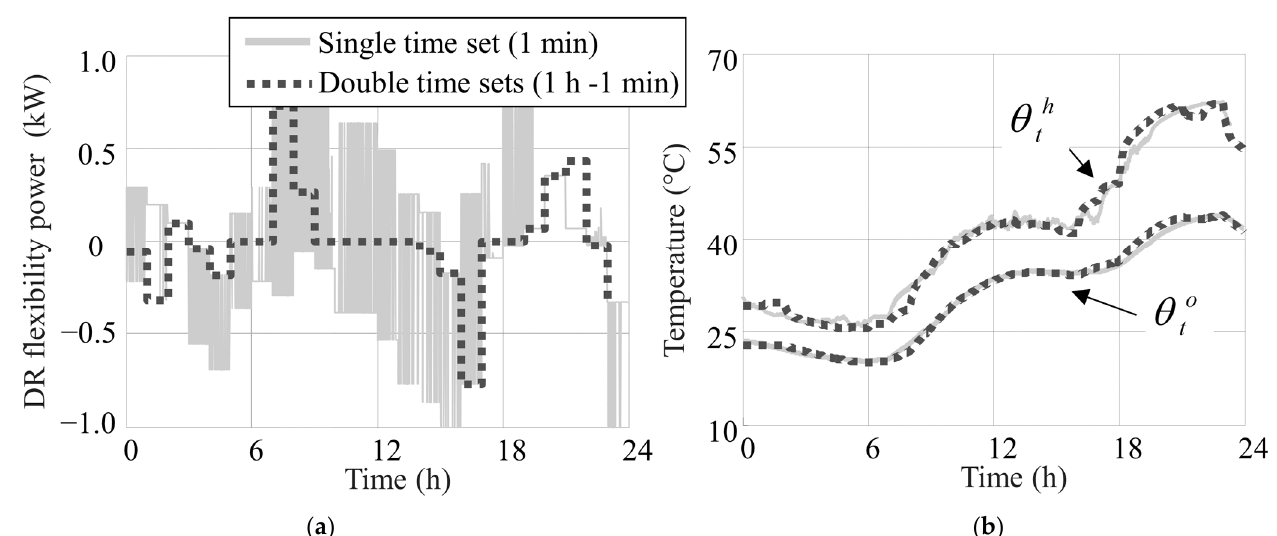
Figure 9. Simulation with single and multiple time sets: ( a ) DR flexibility power; ( b ) transformer temperatures.